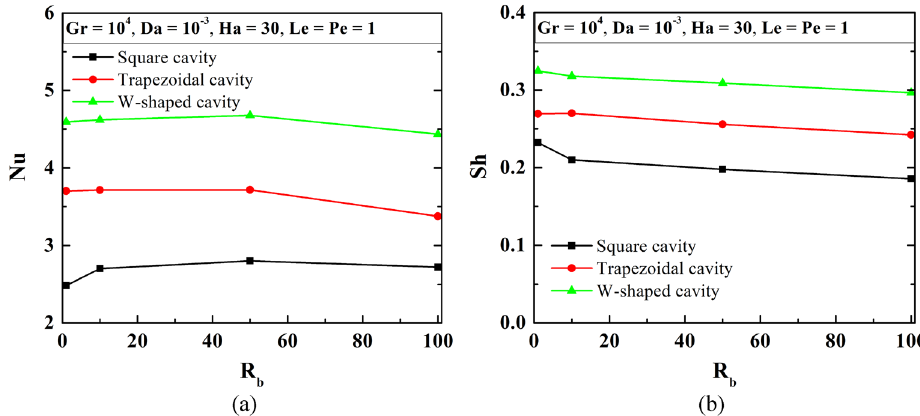
Figure 8. Variation of average values of Nu ( a ), and Sh ( b ) at Le = 1, Pe = 1, Gr = 10 4 , Da = 10 –3 , Ha = 30 changing bioconvection Rayleigh number for square, trapezoidal and W-shaped